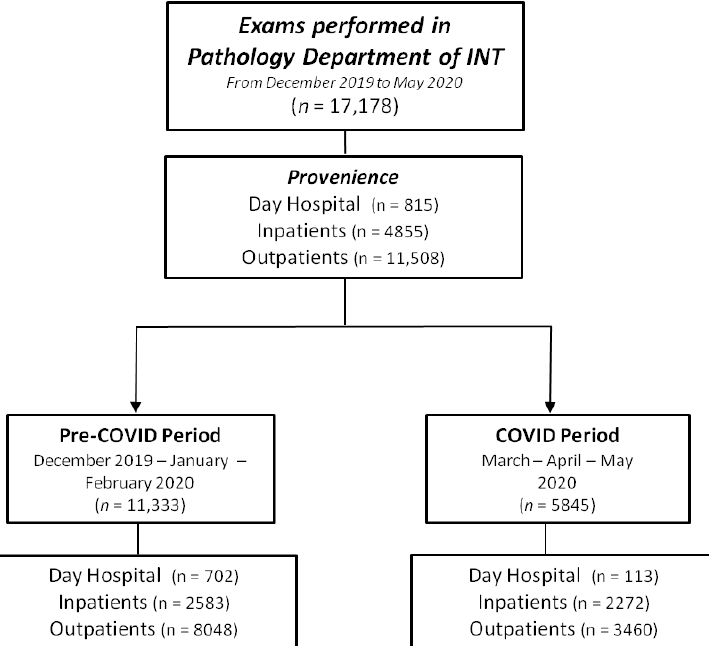
Figure 1. Flowchart of exams performed in pathology department. Abbreviations: INT, Fondazione IRCCS Istituto Nazionale Tumori of Milan (INT).